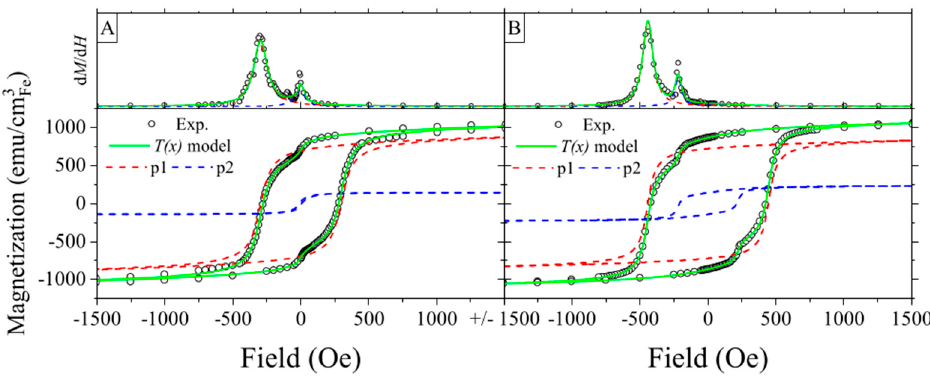
Figure 4. Magnetization curves (bottom graphs) for the S20 sample as-prepared ( A ) and annealed ( B ), and derivatives of the upper branch of hysteresis loops (top graphs). Calculated hystereses of different magnetic phases are shown with dashed lines. Loops were measured in the in-plane geometry.